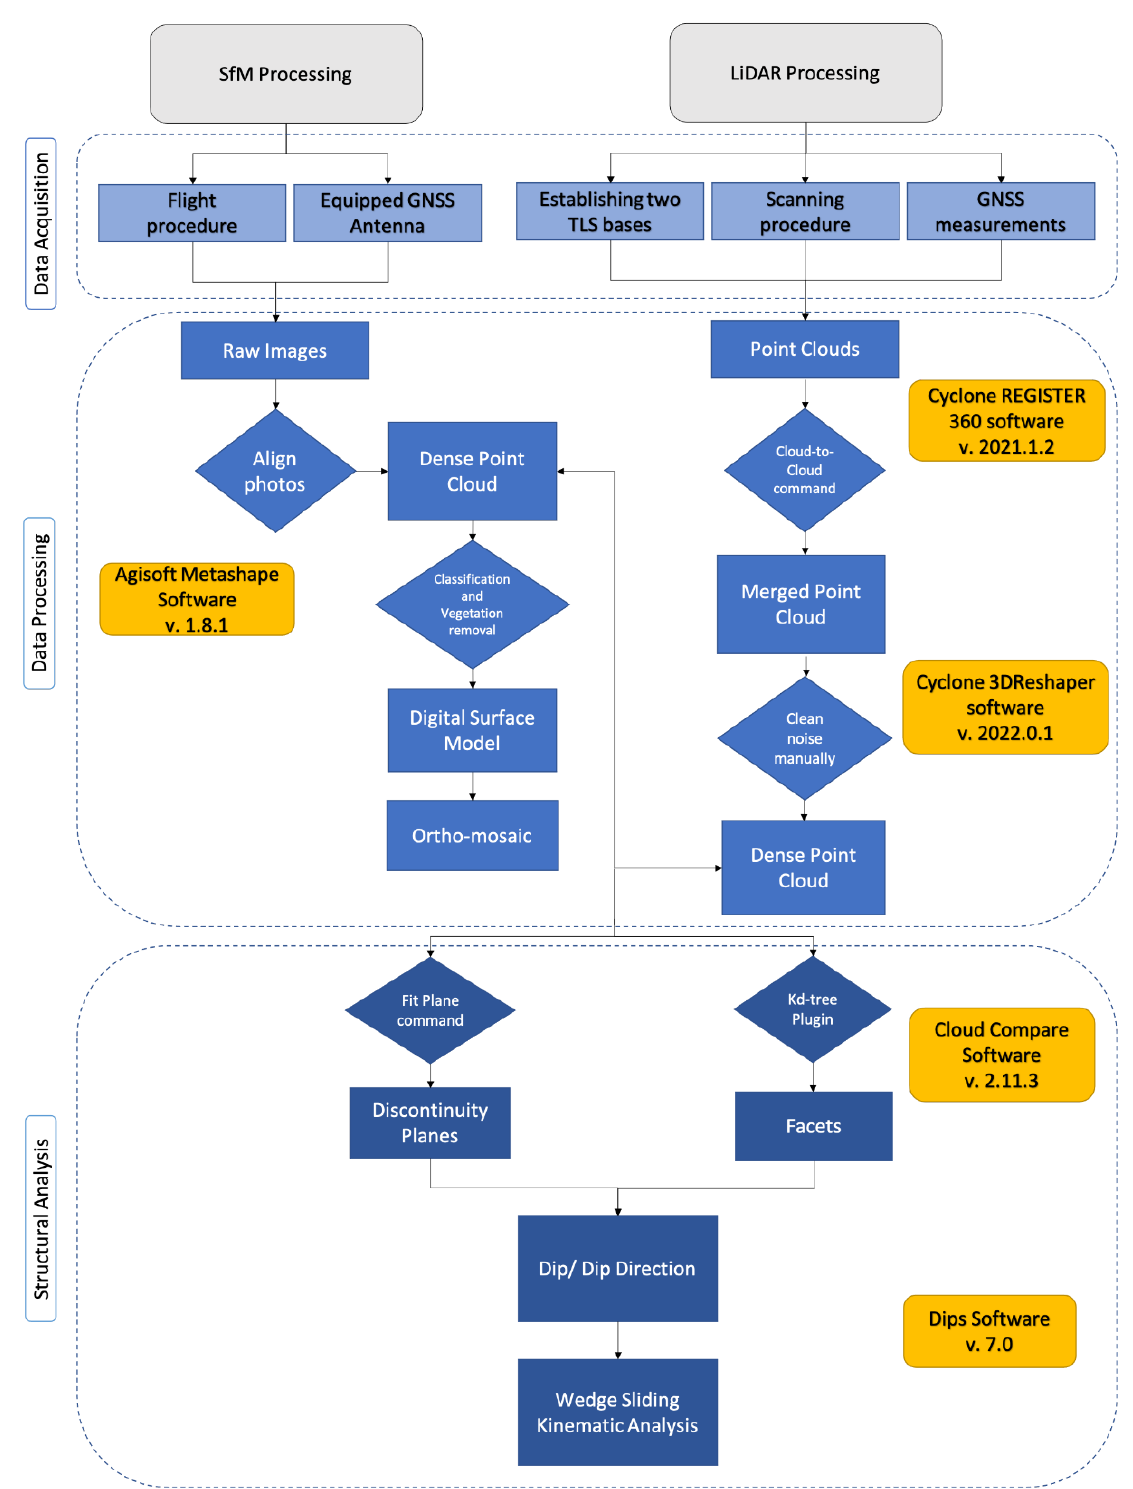
Figure 4. Basic steps of the applied